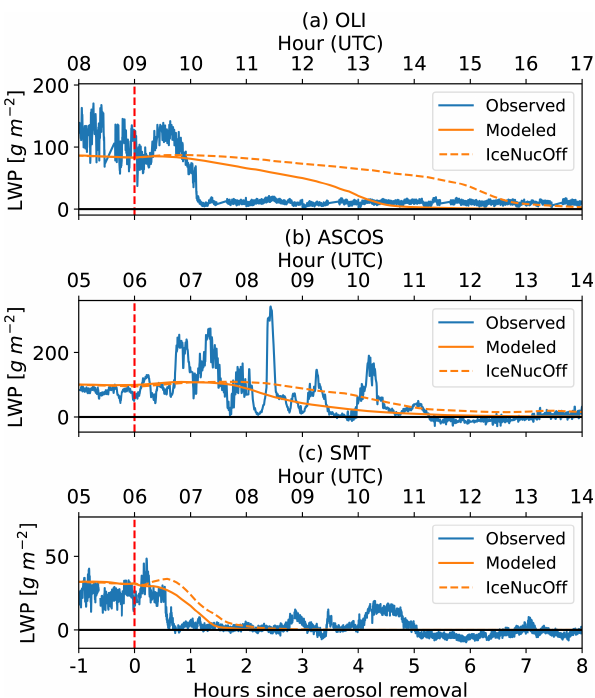
Figure 6. Liquid water path evolution for observations (blue) and modeled domain averages (orange) at (a) OLI, (b) ASCOS, and (c) SMT. The red dashed line denotes the time at which aerosol were removed from the simulations. LWP from simulations in which INP were also removed is shown as dashed orange